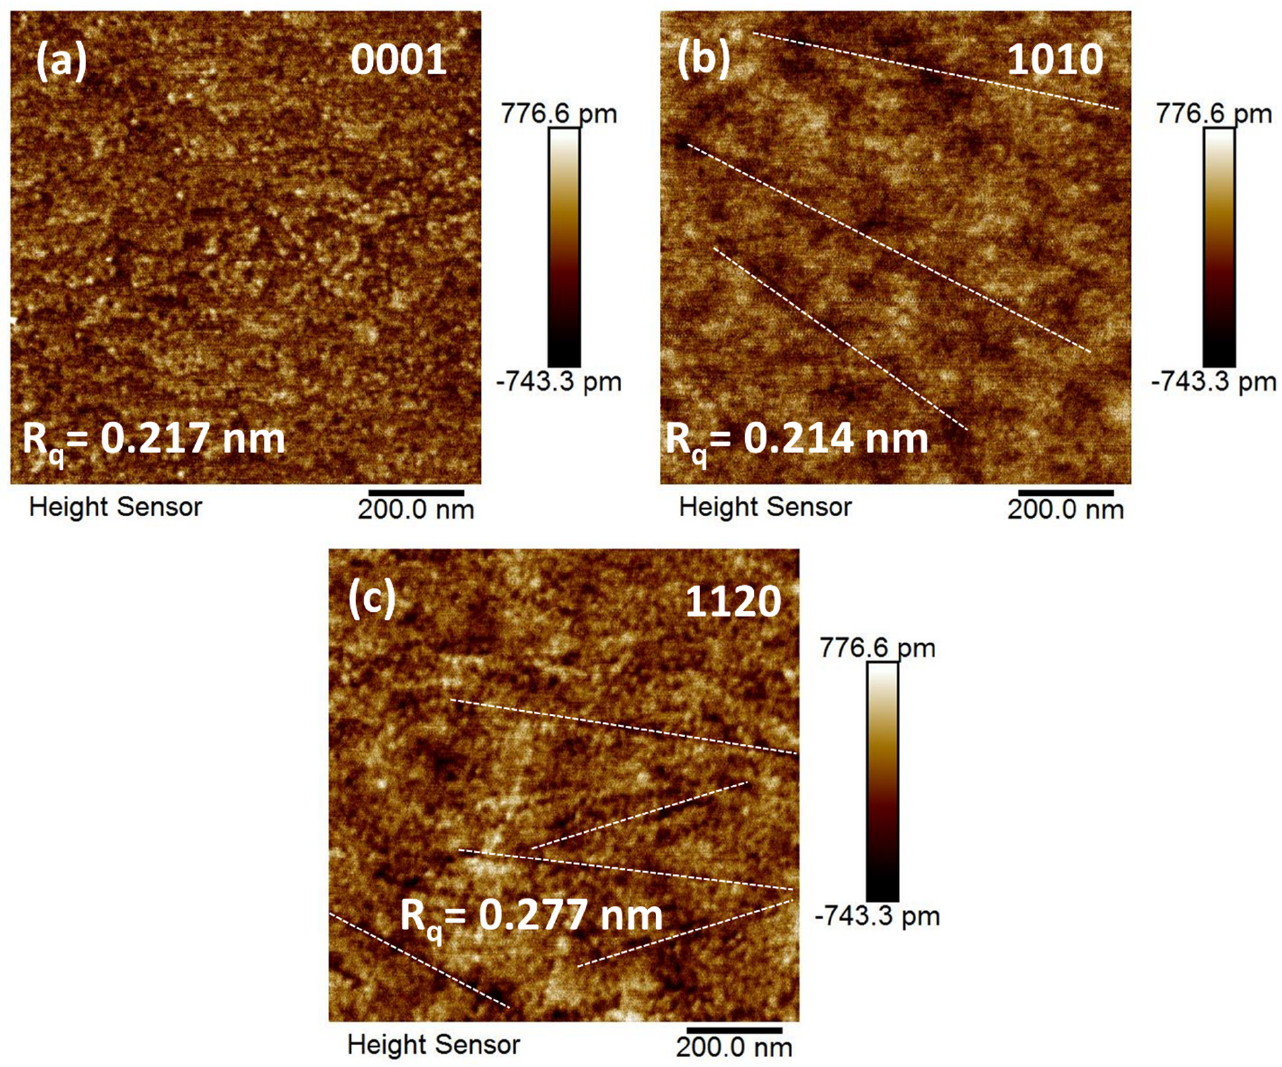
Figure 4. Two-dimensional AFM images of polar ( a ) <0001> and non-polar ( b ) <1010>, ( c ) <1120> ZnO single crystals. The white dashed line indicates the nano-scale cracks on the surface of single crystals. The surface roughness value of each single crystal surface was measured with a minimal standard deviation of 0.035 nm.